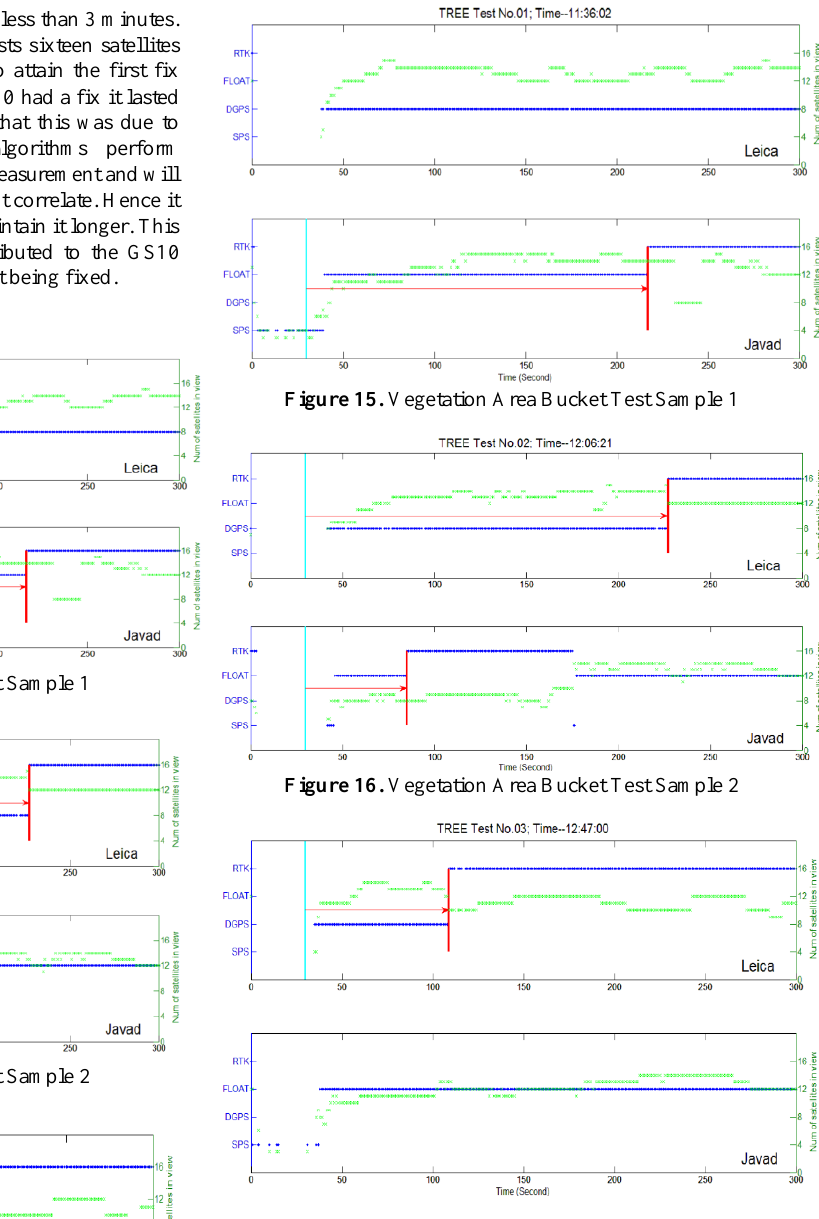
Figure 17. Vegetation Area Bucket Test Sample